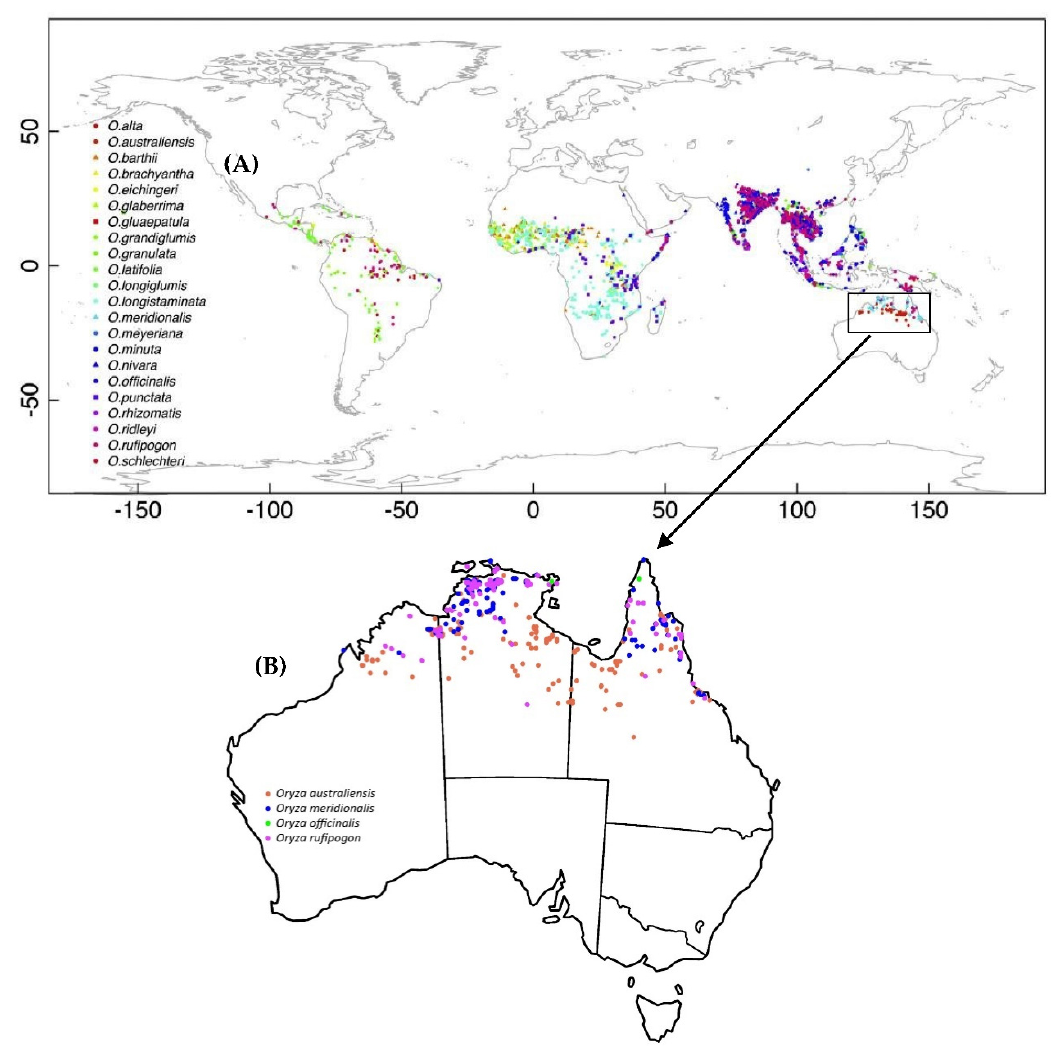
Figure 1. ( A ) Global distribution of all the wild Oryza species as described in [14], the phylogenetics and the genomic constitution of these wild relatives of rice are reviewed in [11]; ( B ) Distribution of wild Oryza species in Australia: O. rufipogon in violet, O. meridionalis in blue, O. officinalis in green, and O. australiensis in red. Based on occurrence records provided by [15].